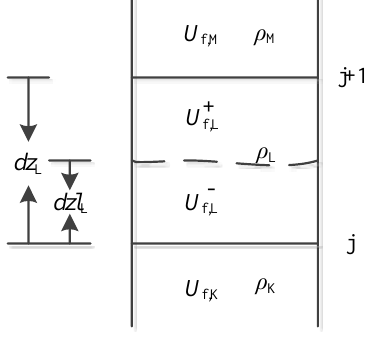
Figure 5. Thermal front in a tank.